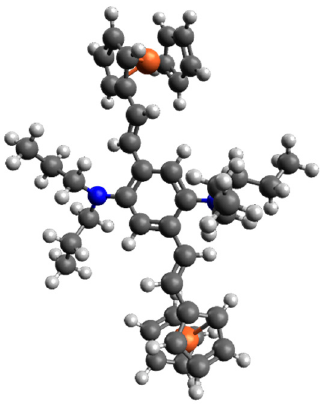
Figure 3. Molecular structure of 3 as result of Orca calculation.